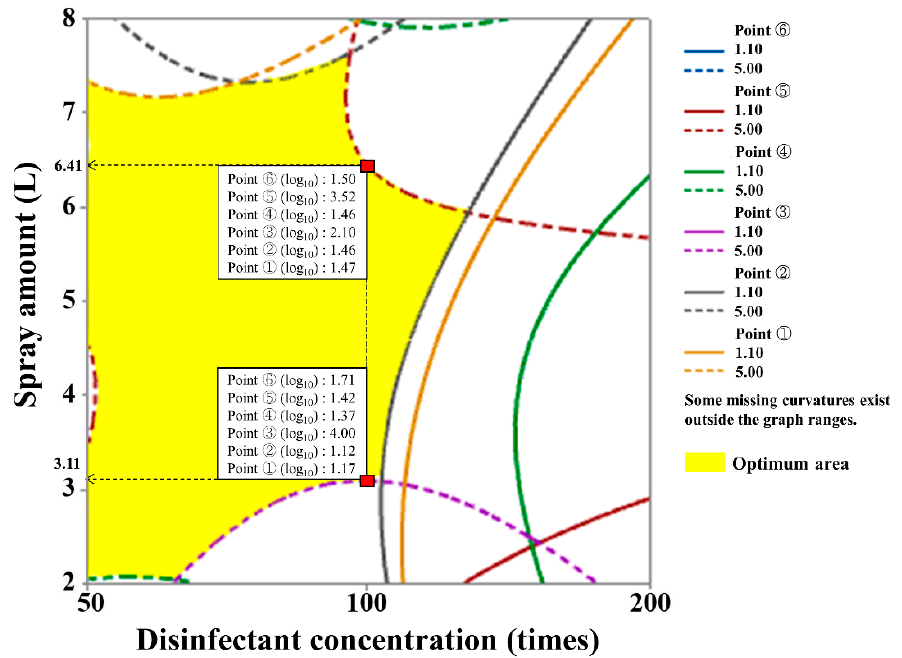
Figure 7. Overlay plot of the disinfectant concentration and spray amount on the disinfection efficiency at each point when the room size is 160 m 3 .